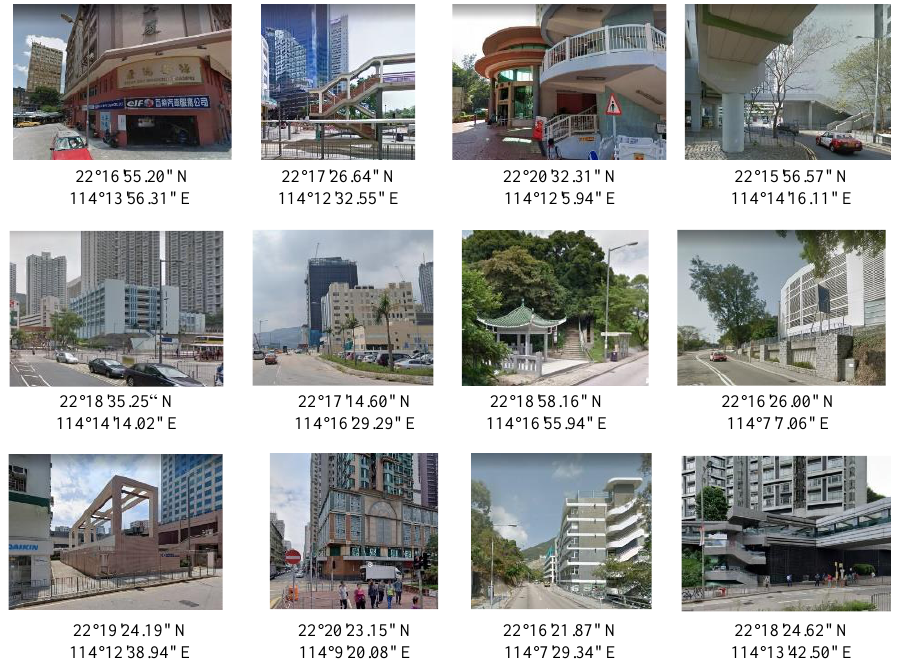
Figure 4. Part of our test dataset: each test image has latitude and longitude